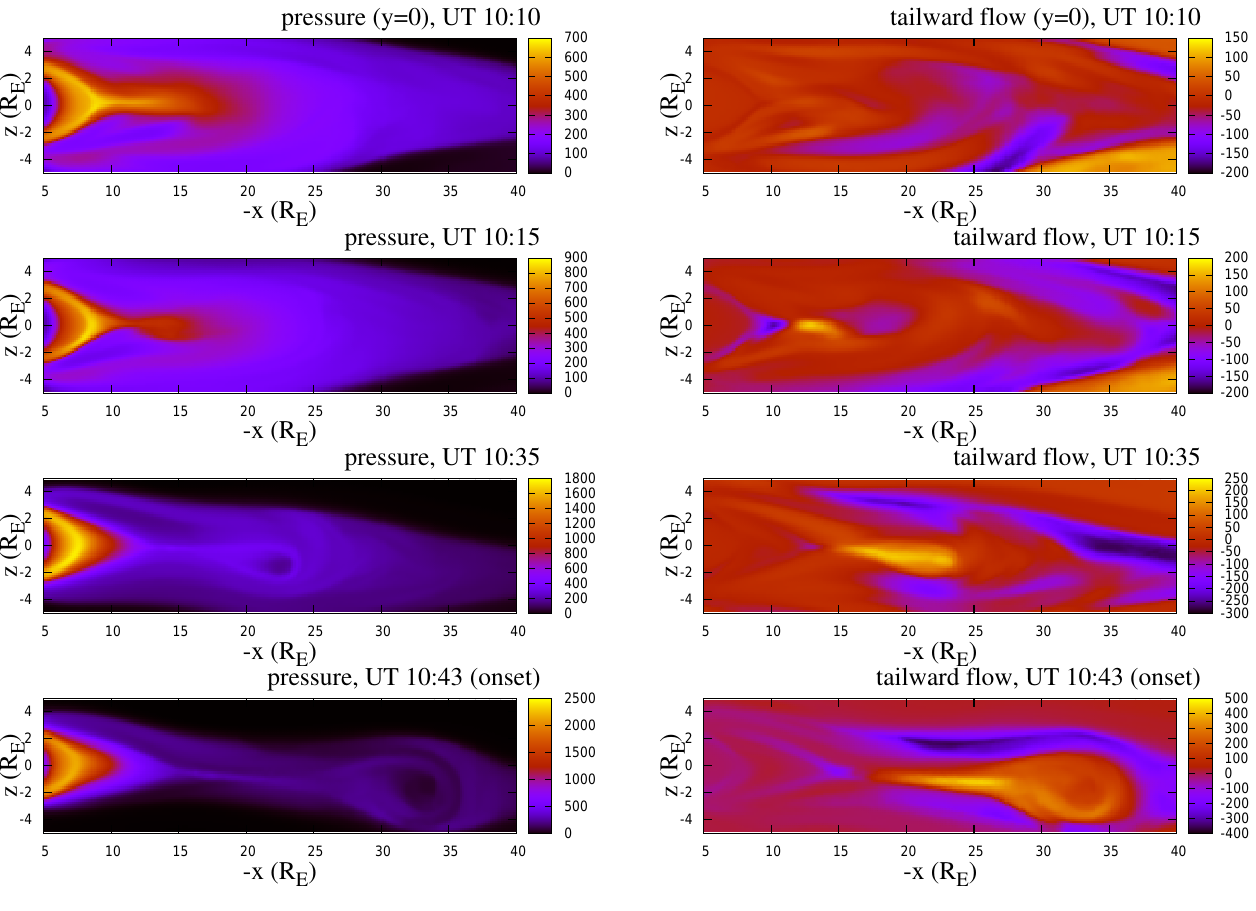
Fig. 2. Pressure (left column) and tailward flow (right column) contours in the meridional plane at four time slices prior to the first aurora